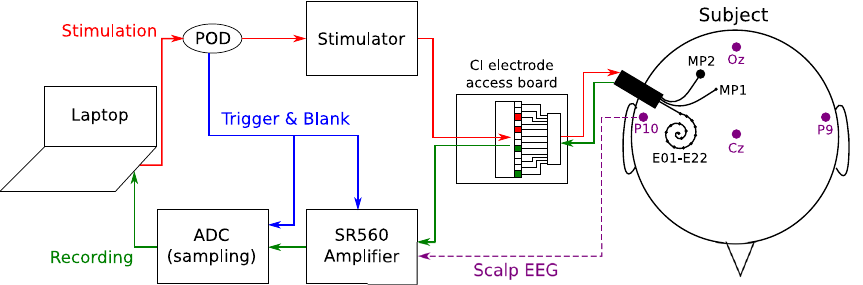
Figure 7. Experimental set-up. The electrical stimulation path is shown in red, and the intracochlear EEG recording path is shown in green. Additional scalp electrodes are placed on the subject’s head, shown in purple. The trigger signal used to synchronize EEG recordings and control the amplifier blanking is shown in